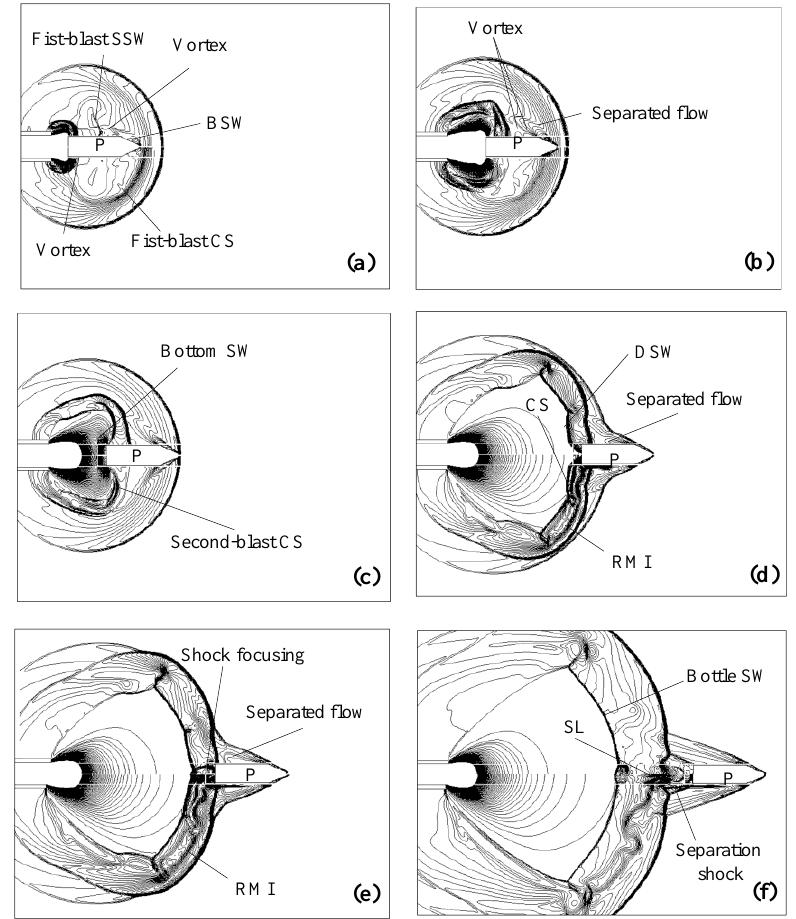
Figure 9. Isopycnic (the lower half) and isobars (the upper half) for cone-ended projectile. ( a ) t = 0.590 ms; ( b ) t = 0.671 ms; ( c ) t = 0.736 ms; ( d ) t = 0.989 ms; ( e ) t = 1.091 ms; ( f ) t = 1.371 ms.